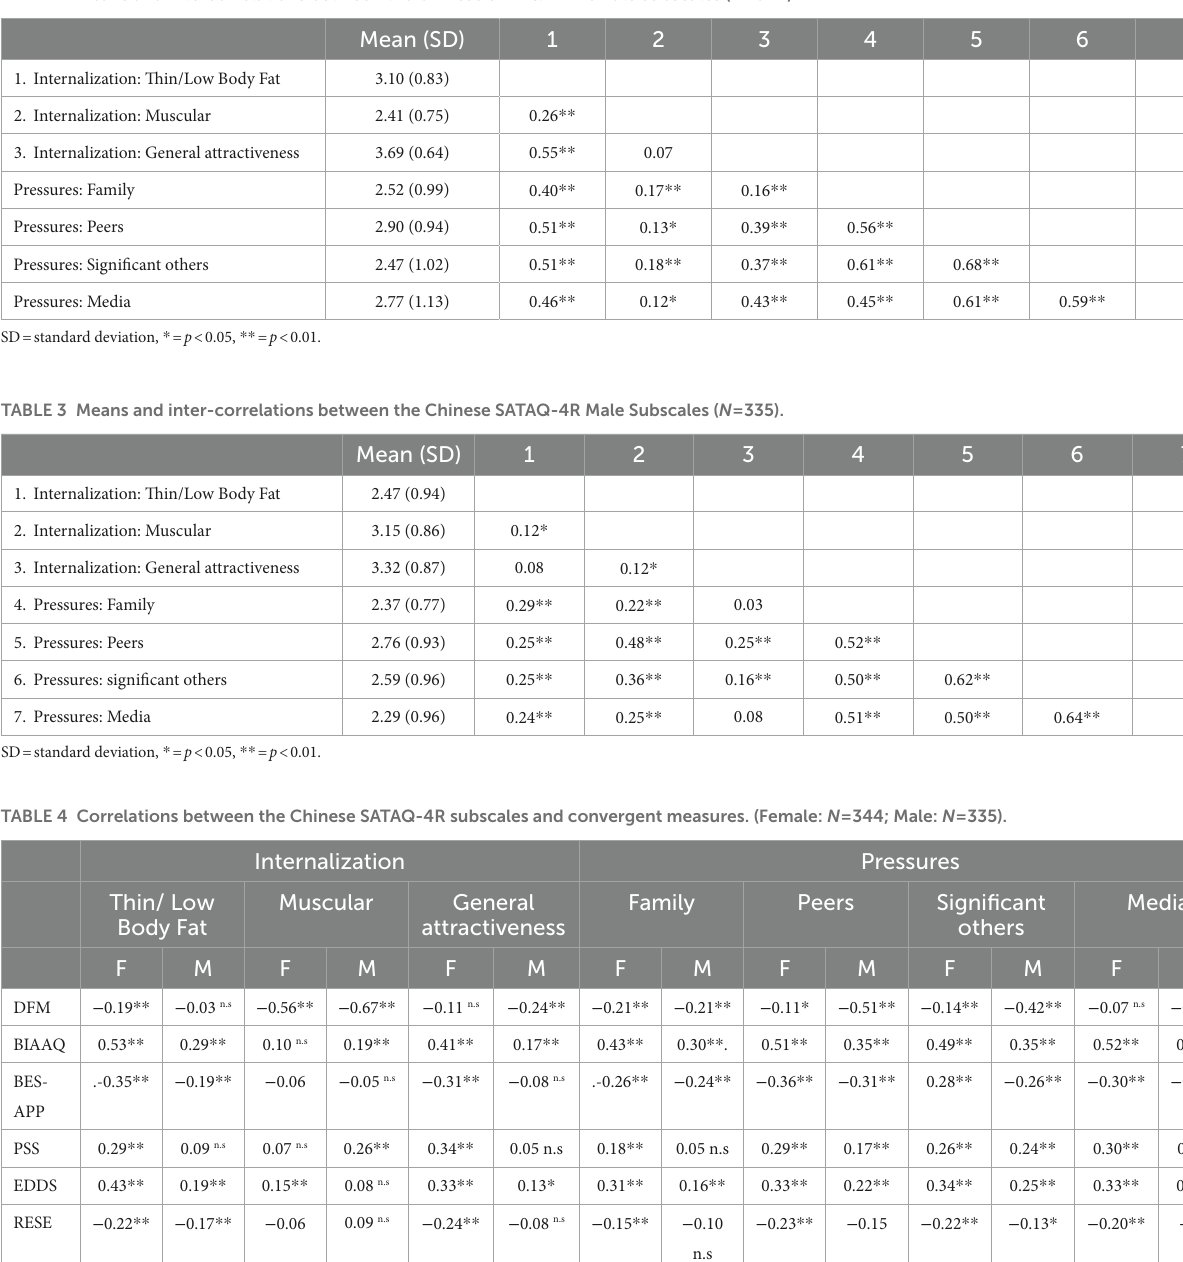
TABLE 2 Means and intercorrelations between the Chinese SATAQ-4R Female Subscales ( N = 344).